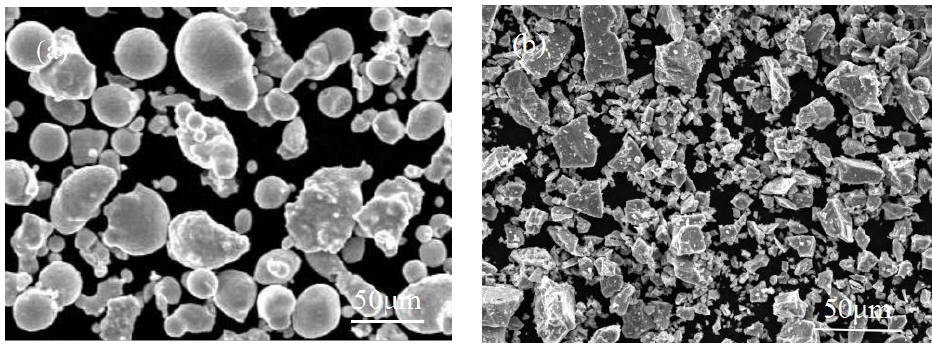
Figure 1. Morphologies of Cu10Sn powders ( a ) and TiH 2 powders ( b ).